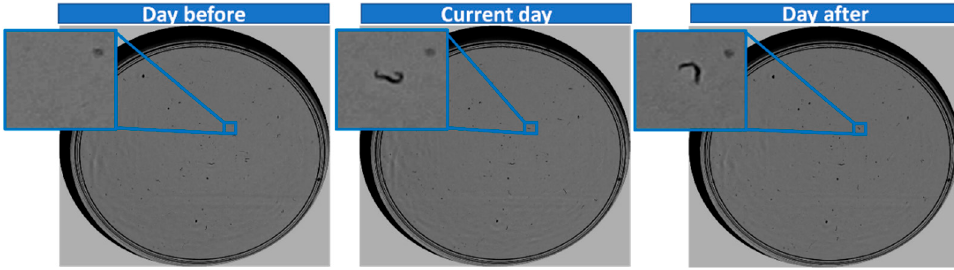
Figure 3. Generation of an input sequence.